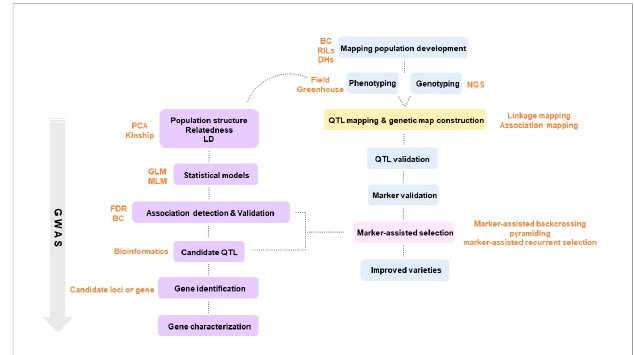
FIGURE 1 Schematic diagram of plant breeding using molecular